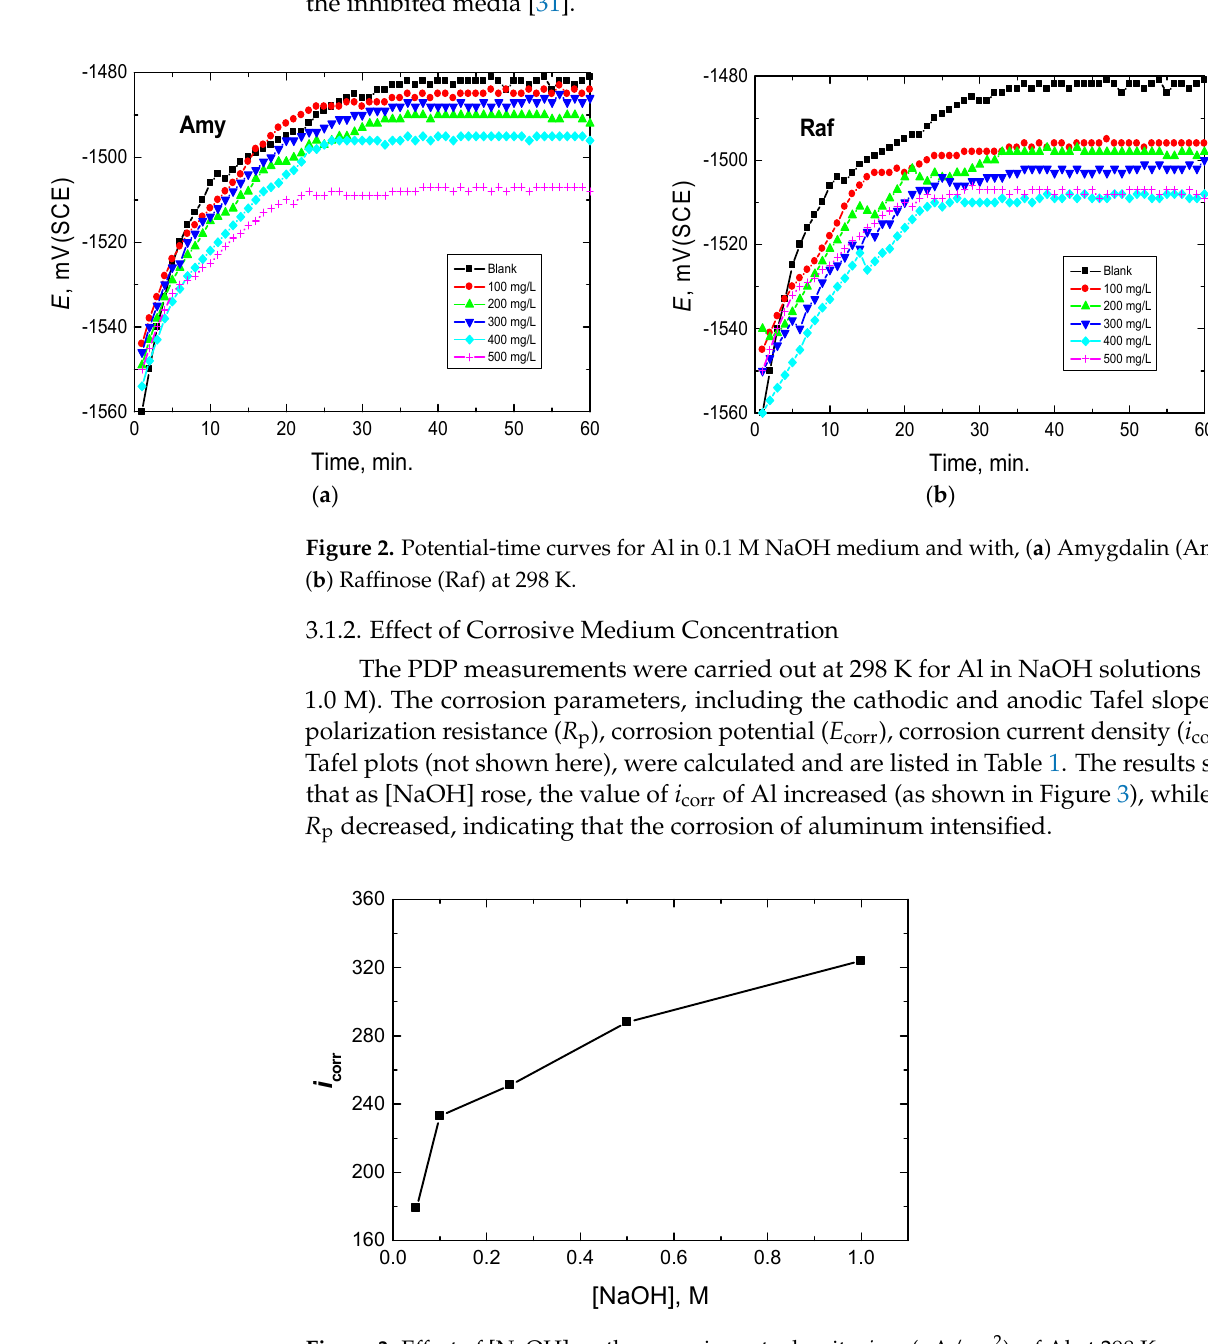
2 ), of Al at 298 corr ( µ A/cm